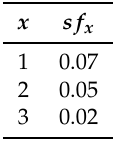
Table 4. Generator x sensitivity